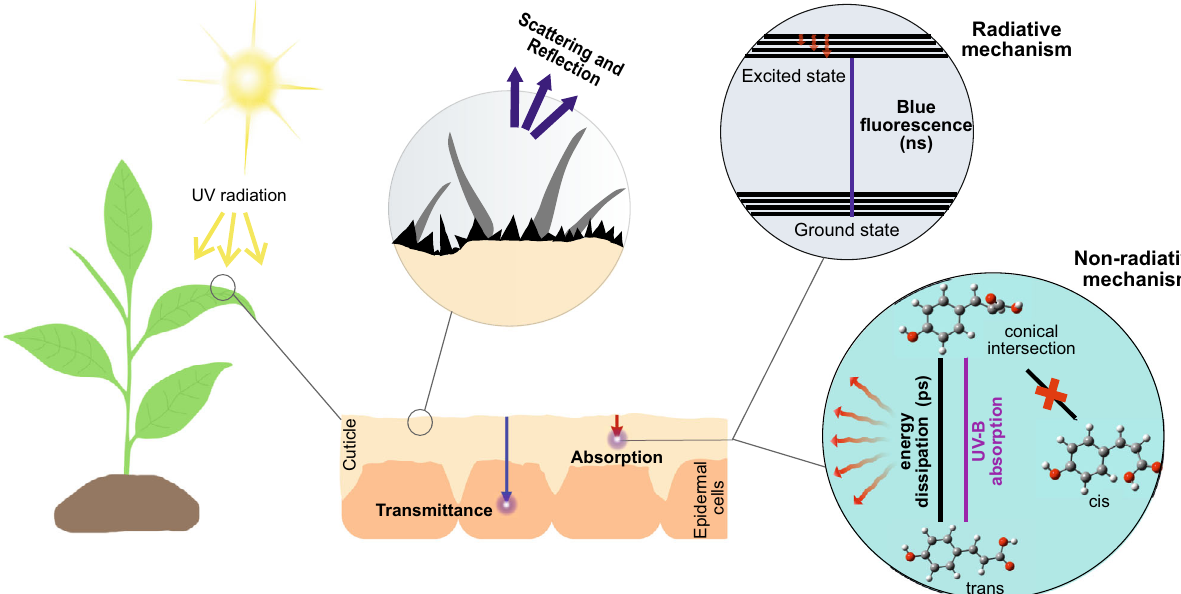
Fig. 5 Schematics of the photoprotection processes observed in plant cuticles. Of the UV light reaching the surface of the cuticle, a small fraction can be re fl ected or scattered due to the presence of trichomes, crystallised wax structures, etc. A variable fraction of UV light is transmitted to the epidermal cell. Within the UV-B range, transmittance varies among species from a negligible 0.3% to almost 50% in species with a very little amount of cuticle phenolics, such as Brassica oleracea and Beta vulgaris . Most of the UV light reaching the surface of the plant is thus absorbed by the phenolic compounds present in the cuticle. Part of this absorbed energy can be released with the emission of blueish fl uorescence. However, most of the absorbed UV light seems to be dissipated via non-radiative mechanisms, being an ultrafast change in molecular geometry within the trans conformation of the phenolic acid and return to the ground state considered in the present